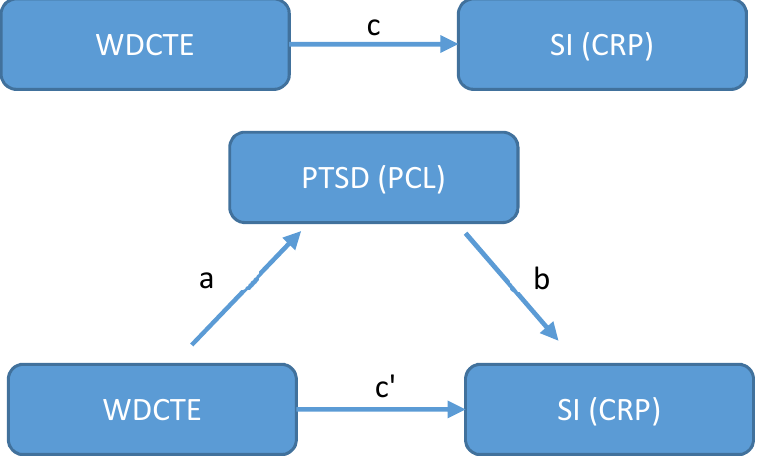
Figure 1. Diagrams for mediation analysis. We consider the effect of WTC dust cloud traumatic exposure (WDCTE) on systemic inflammation (SI), i.e., CRP level, is potentially mediated by PTSD (PCL score). Path c and c′ are the total effect and direct effect of WDCTE on CRP level; path a is the effect of WDCTE on PTSD (PCL); path b is the effect of PTSD (PCL) on CRP level.